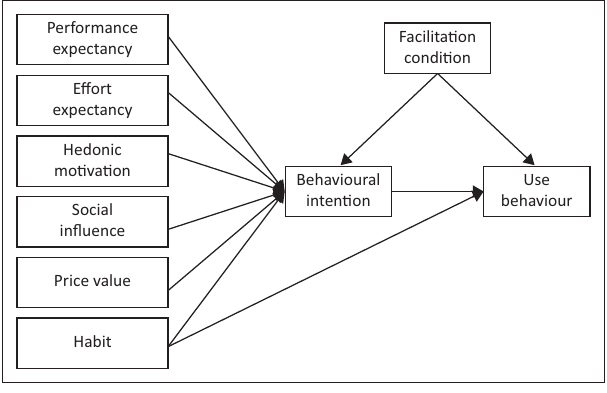
FIGURE 1: Unified Theory of Technology Acceptance and Use